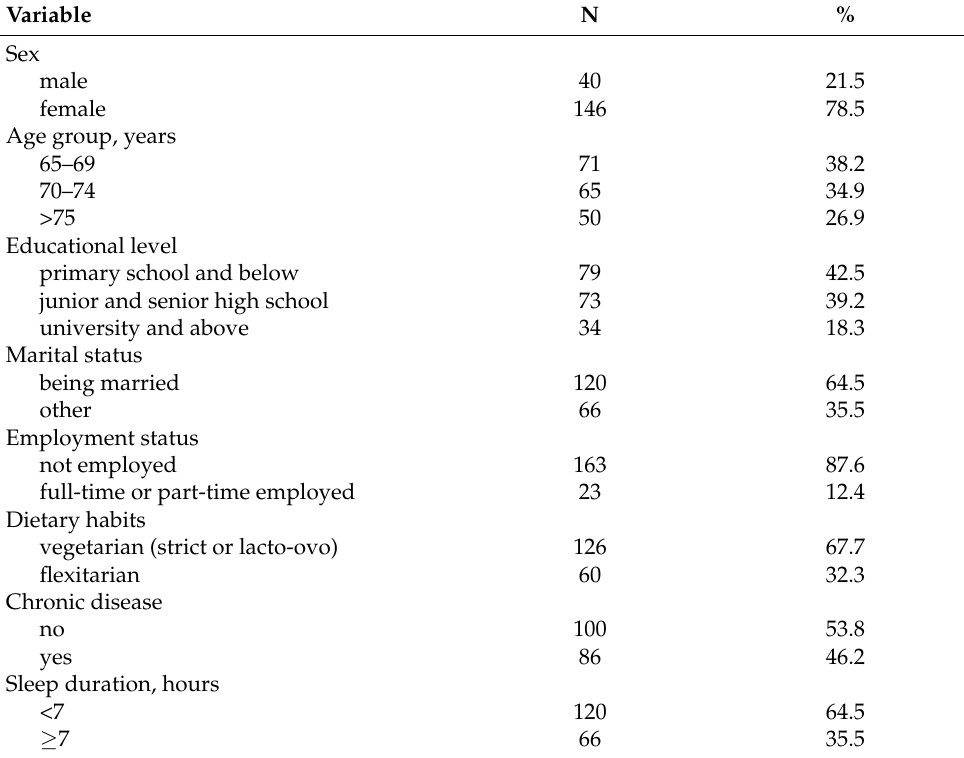
Table 1. Demographic information (N =